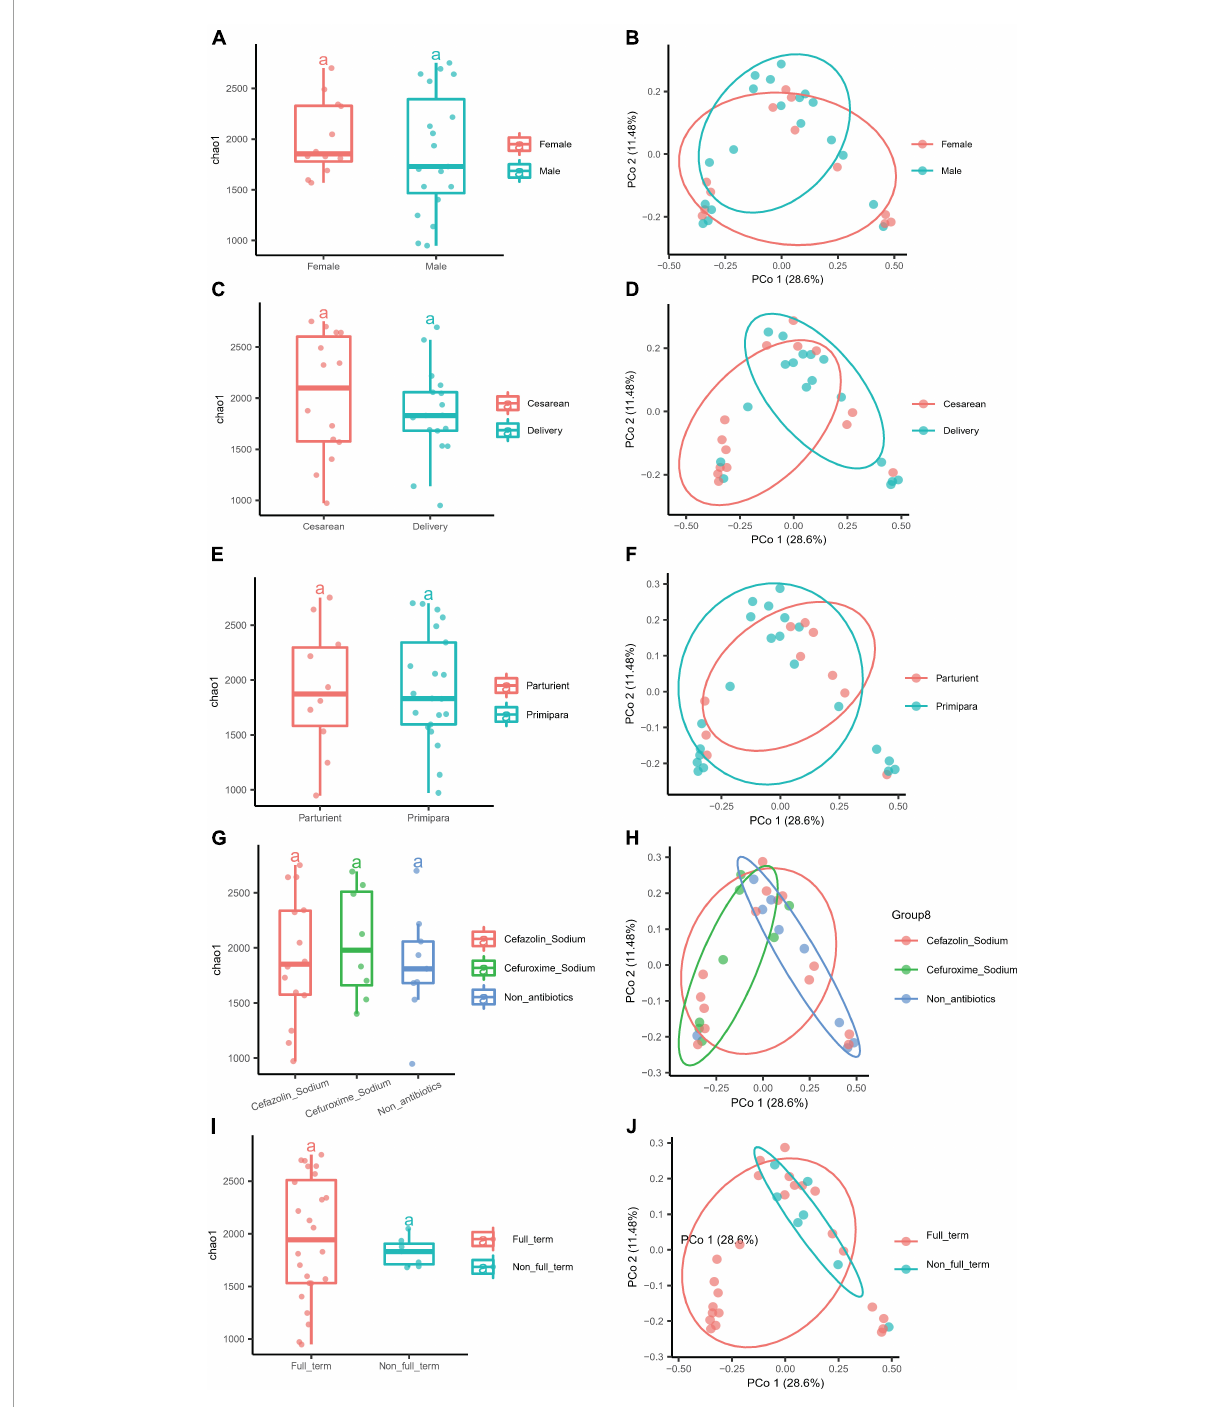
FIGURE4 Different factors had no influence on the α and β diversity of the microbiota of BM. (A) The α diversity of newborn gender (Female and Male). (B) The β diversity of newborn gender (Female and Male). (C) The α diversity of the delivery mode (Cesarean and Delivery). (D) The β diversity of the delivery mode (Cesarean and Delivery). (E) The α diversity of parity (Parturient and Primipara), and (F) the β diversity of parity (Parturient and Primipara). (G) The α diversity of intrapartum antibiotic prophylaxis (Cefazolin sodium, Cefuroxime sodium, and Non-antibiotics), and (H) the β diversity of intrapartum antibiotics prophylaxis (Cefazolin sodium, Cefuroxime sodium, and Non-antibiotics). (I) The α diversity of gestational age (Full-term and Non-full-term). (J) The β diversity of gestational age (Full-term and